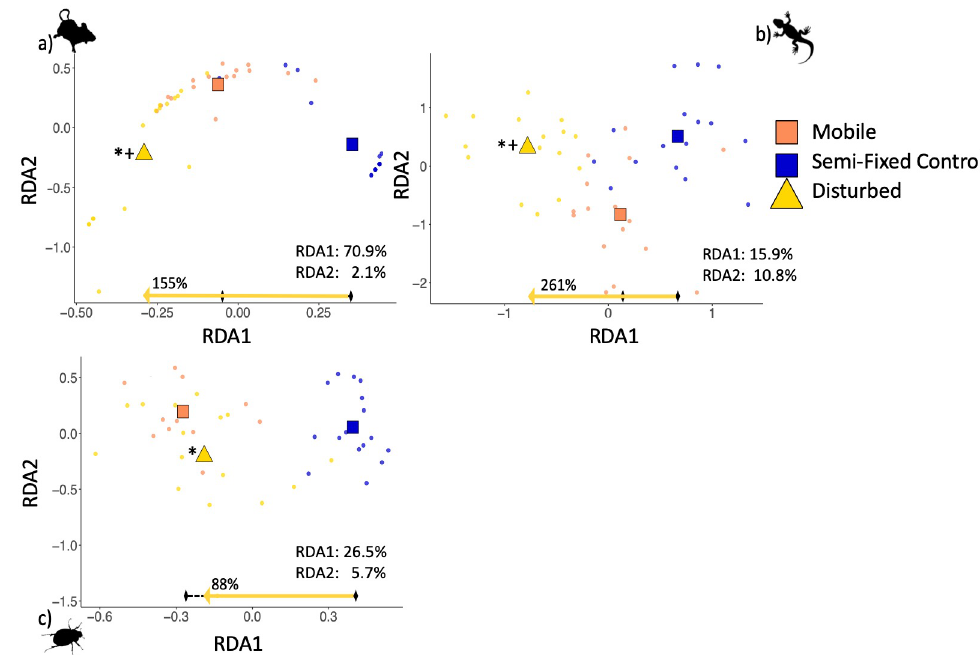
Figure 7. Redundancy analysis for ( a ) rodents, ( b ) reptiles and ( c ) beetles in disturbed dunes (o ff -road vehicle disturbance) compared to semi-fixed untreated (control) and mobile dunes (reference). Distance bars along the 1st RDA axis show the treatment e ff ect (yellow arrow) as a percentage of total distance between control and reference (black dashed); the % is calculated under the scenario that pre-disturbance state was semi-fixed. Significant di ff erences were tested using pairwise Permanova. * and + represent p < 0.05 for treated dunes compared to control and reference dunes,